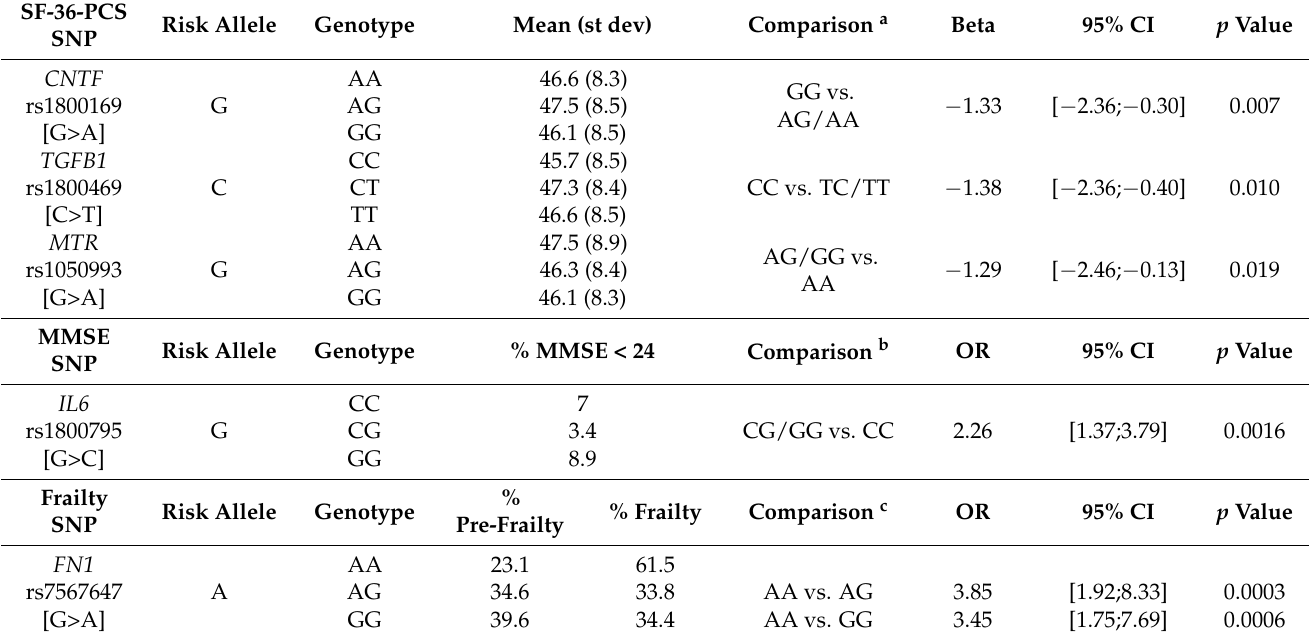
Table 2. Summary statistics of significant SNP associations with psychological parameters and with